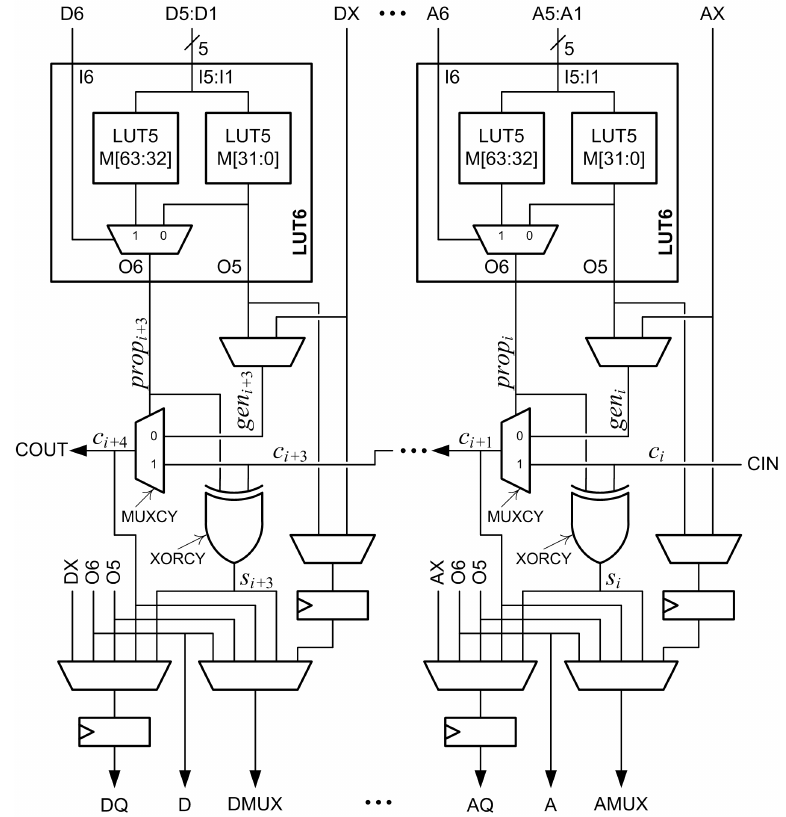
Figure 1. Partial diagram of a Xilinx 7 Series configurable logic block (CLB)